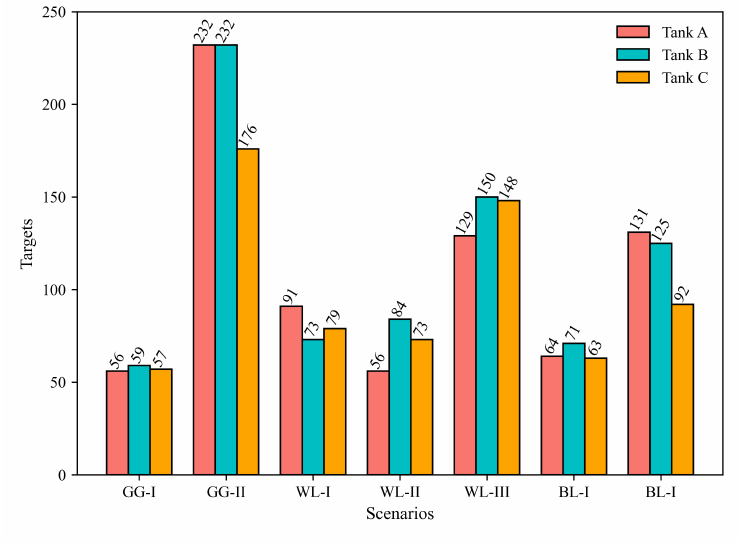
Figure 2. Object distribution in different scenes.